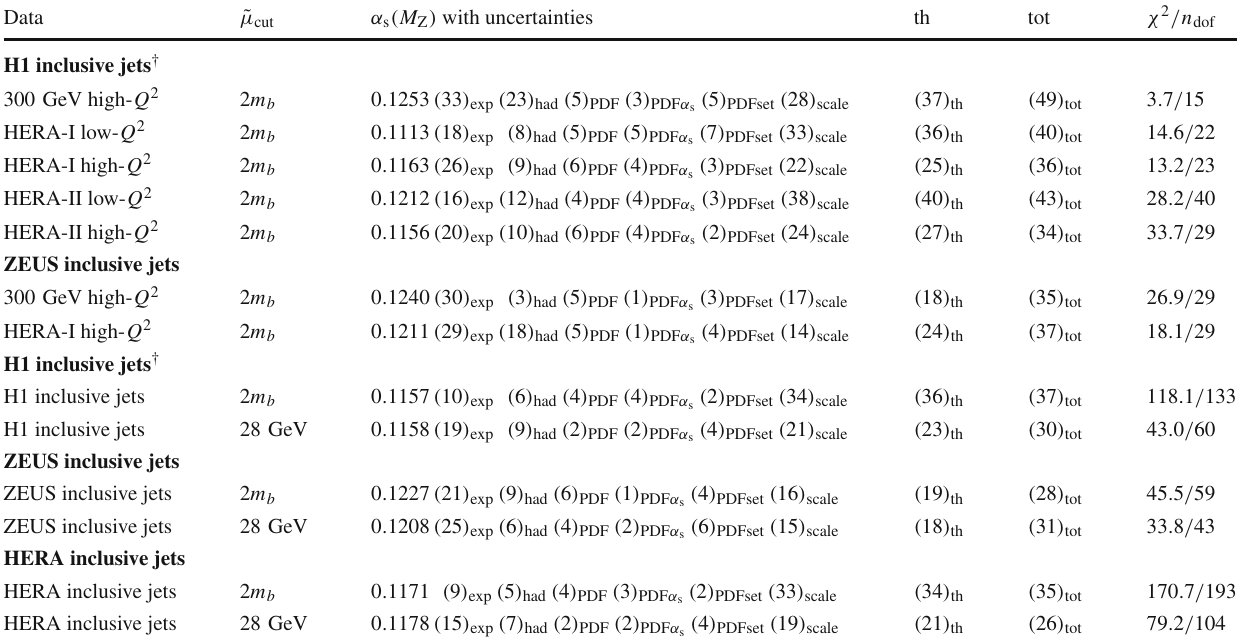
Table 1 A summary of values of α s ( M Z ) from fits to HERA inclusive jetcrosssectionmeasurementsusingNNLOpredictions.Theuncertain- ties denote the experimental (exp), hadronisation (had), PDF, PDF α s , PDFset and scale uncertainties as described in the text. The rightmost